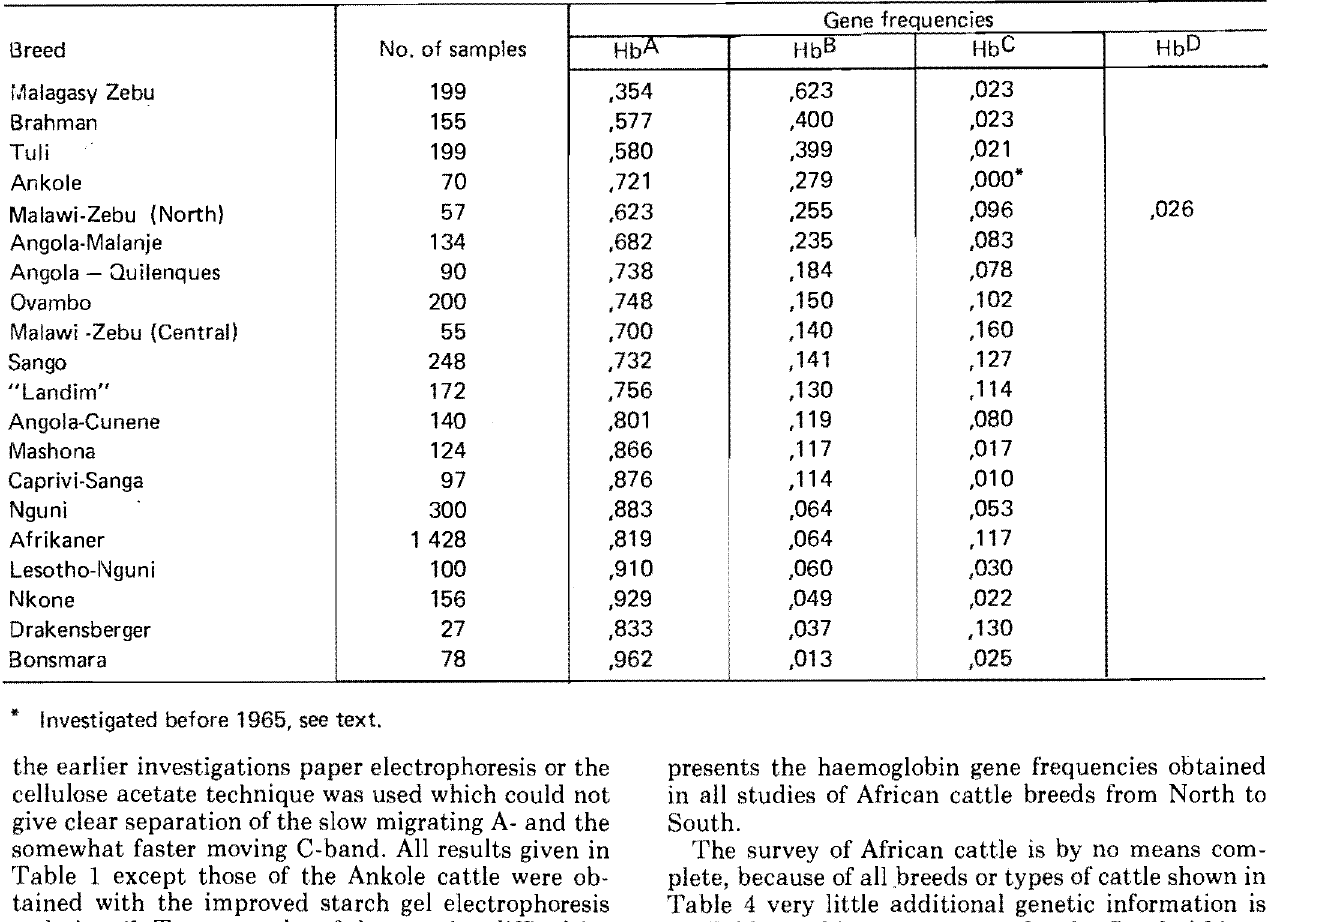
HAEMOGLOBIN GENE FREQUENCIES IN INDIGENOUS CATTLE BREEDS IN SOUTHERN AFRICA.